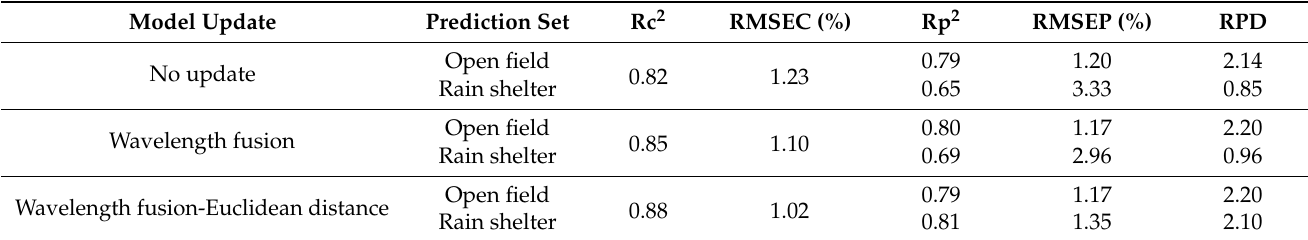
Table 5. Prediction results of SSC after model